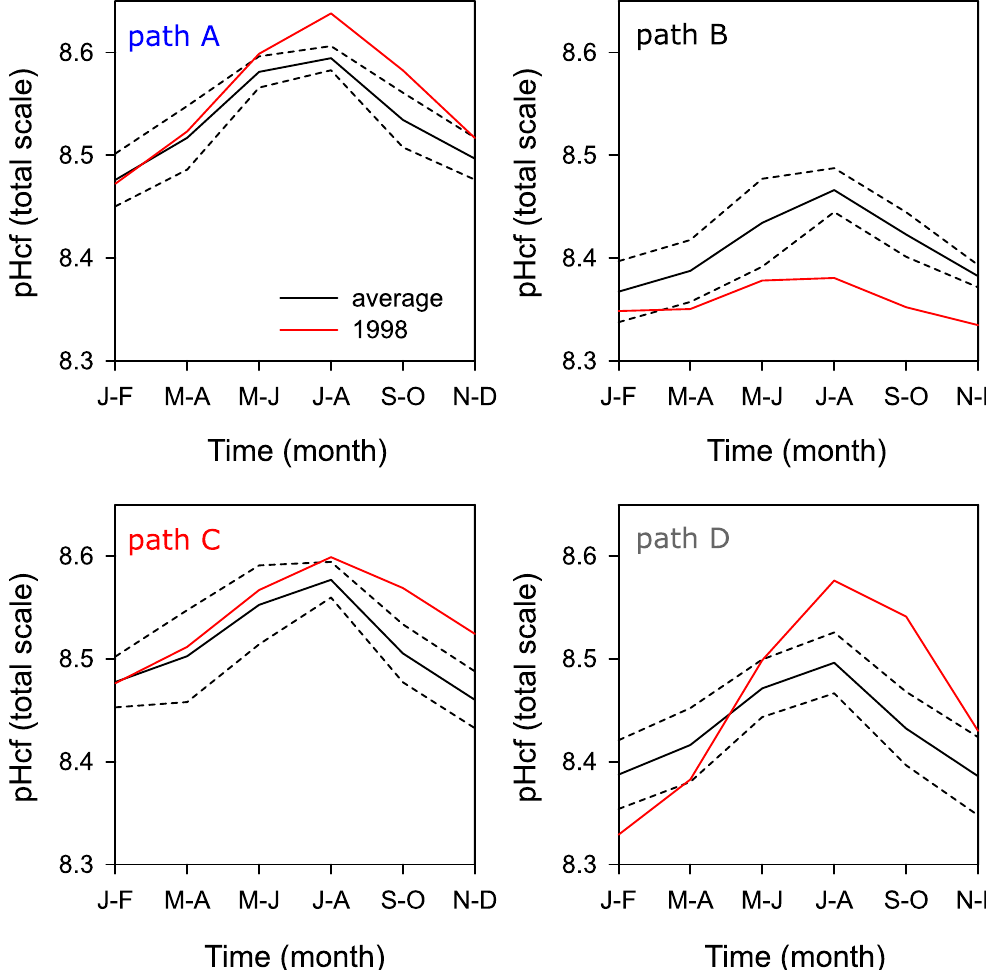
Figure 6. Bimonthly (interpolated) mean climatology in coral δ 11 B-pH cf (black line) compared to the seasonal variability observed during 1998 (red line) for four different sample paths (see Fig. 2), the dashed lines represent one standard deviation from the mean